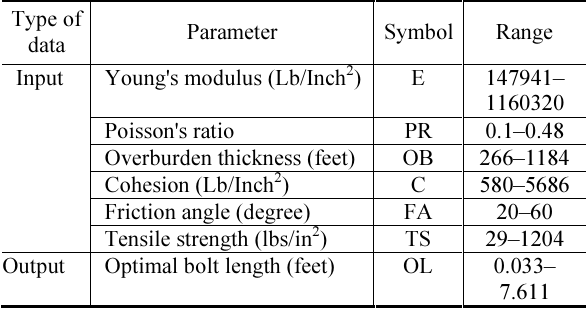
Table 1. Input and output parameters (Luo